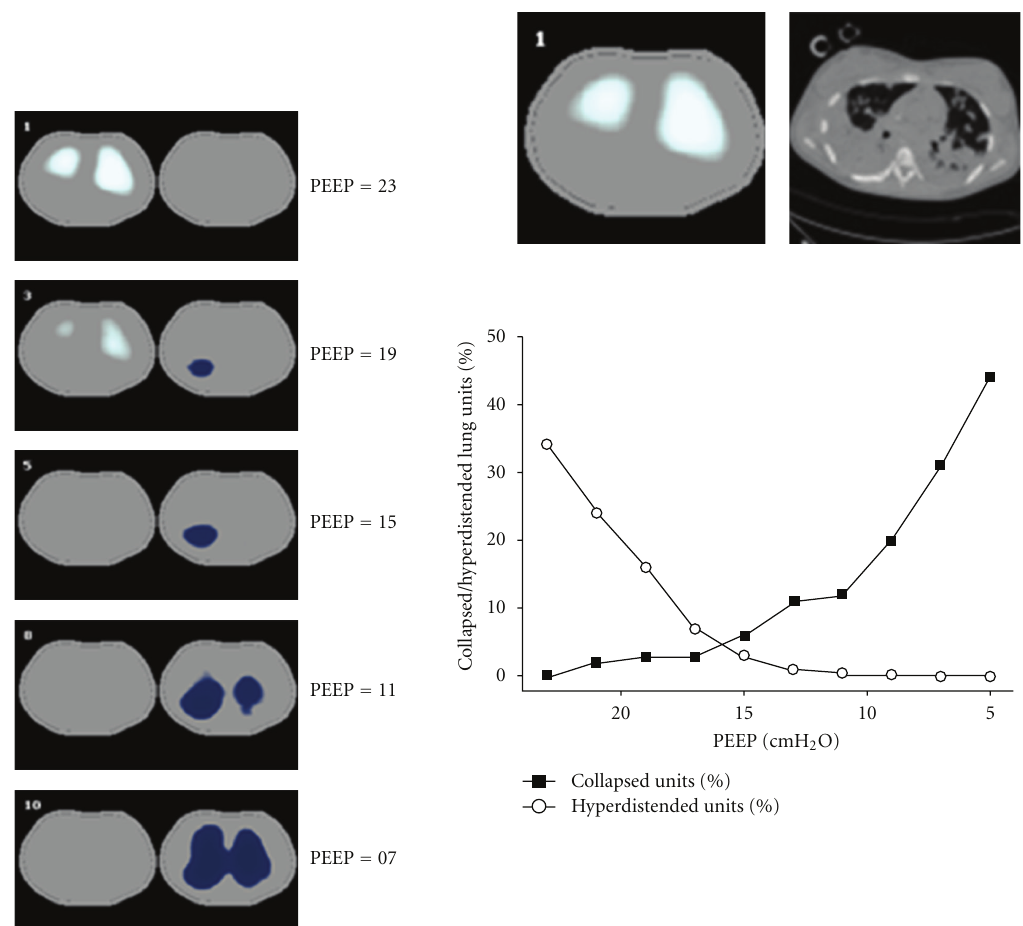
Figure 3: Peep titration with electrical impedance tomography in a patient with ARDS associated with H1N1-influenza virus infection. Legend: sequence of functional EIT images showing the progression of collapse along decremental PEEP levels (in blue, left panel) associated with progressive relief of overdistension (in white, left panel). Collapse was more prominent in the right lung. After analyzing the sequence of EIT images, the PEEP selected for this patient was 17cmH 2 O, believed to represent the best compromise between collapse and overdistension. According to the ARDSNet PEEP/FIO 2 table, this patient had been ventilated with a PEEP = 24cmH 2 O in the previous 48 hours. The patient was weaned from ventilator 3 days